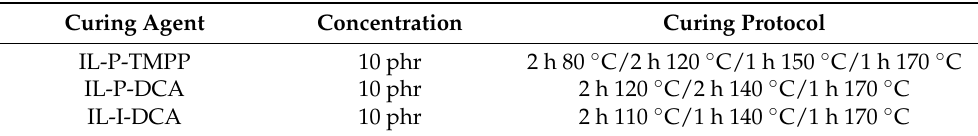
Table 3. Curing protocols for the ILs.